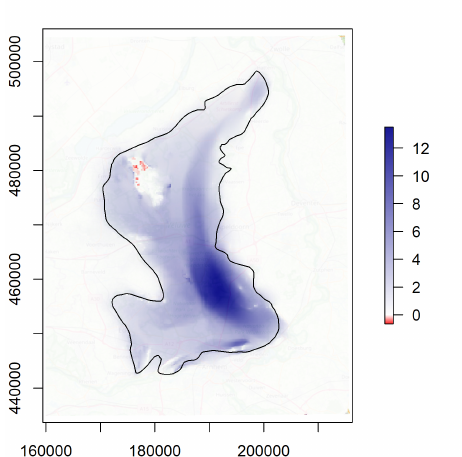
Figure 9. Difference in mean groundwater level (m) between historical land use (1850) and current land use (2008) simulated over 1986–2016. The boundary of the Veluwe area is indicated in